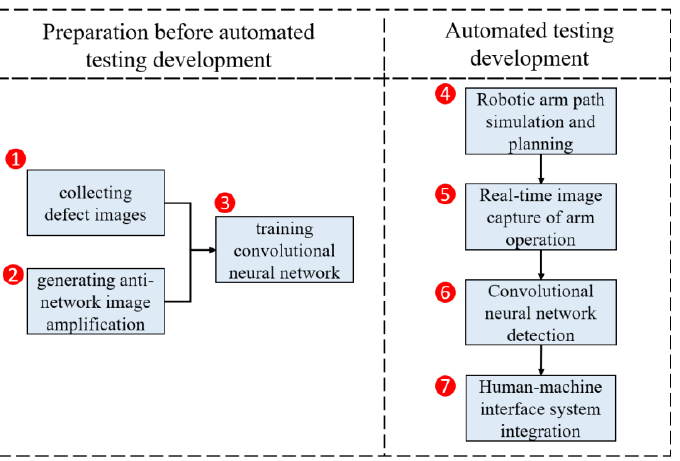
Figure 10. Flowchart showing the experiments conducted in this study.